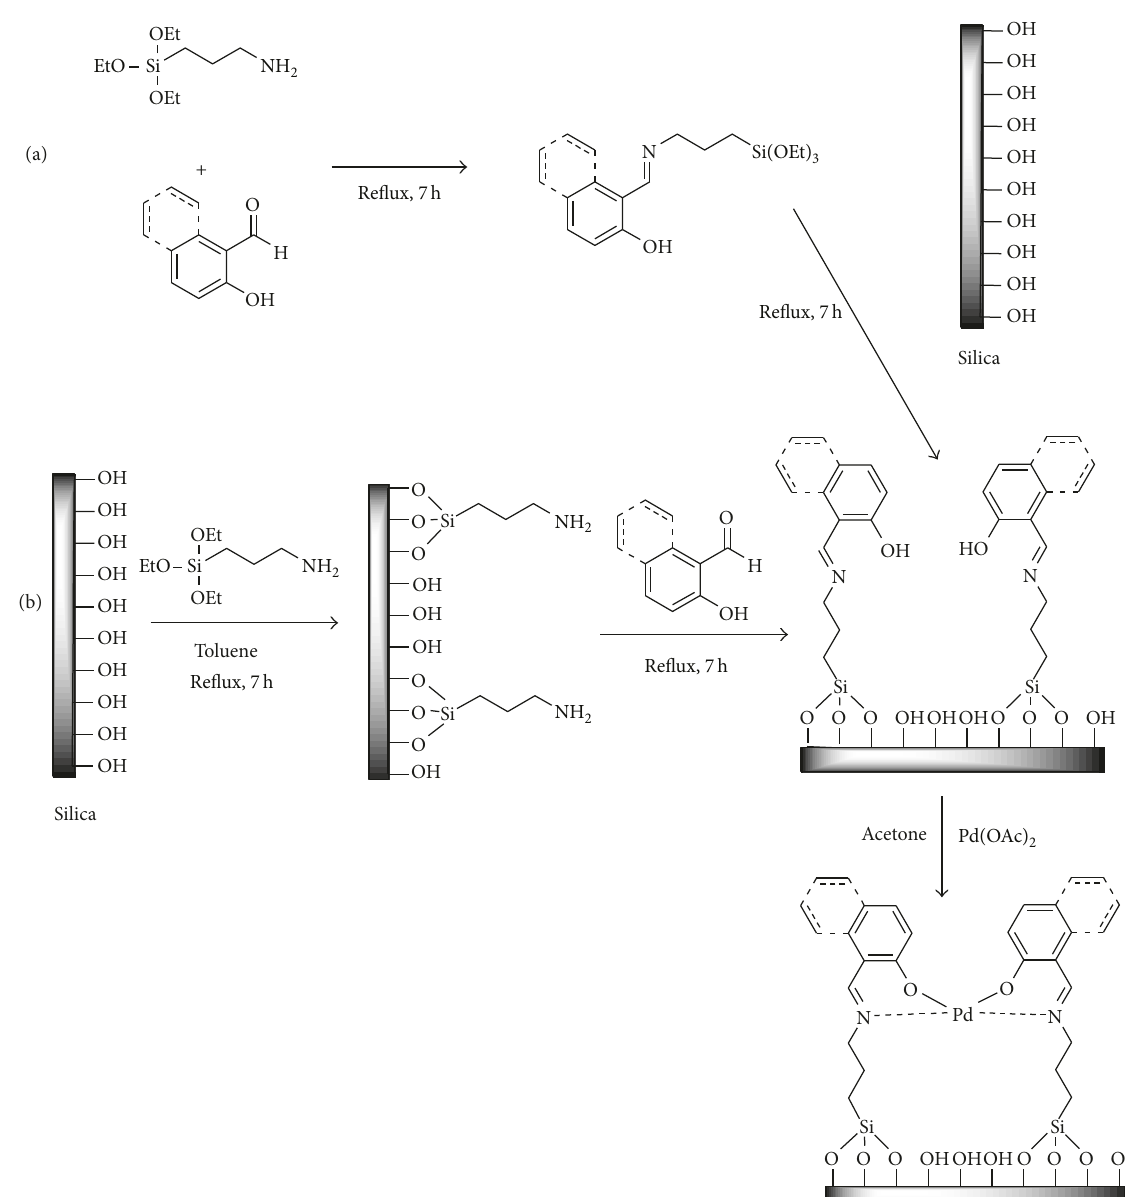
Scheme 1: Synthetic strategy for the preparation of the silica gel supported Pd catalyst. (a) Homogeneous route for mesoporous silica functionalization (method A) and (b) heterogeneous route for mesoporous silica functionalization (method